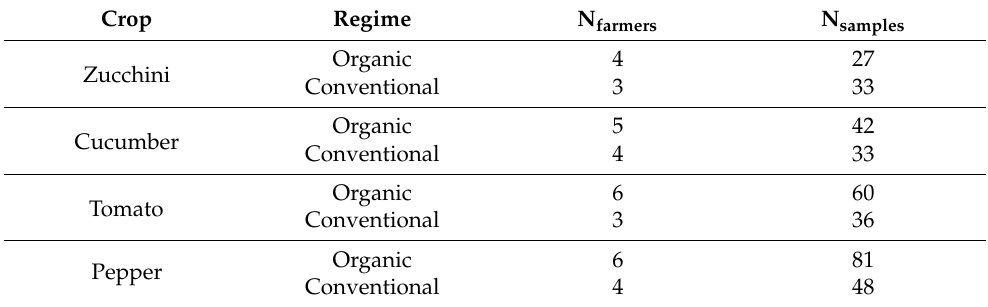
Table 1. Summary of the samples collected for each agricultural crop and regime (organic or conventional).